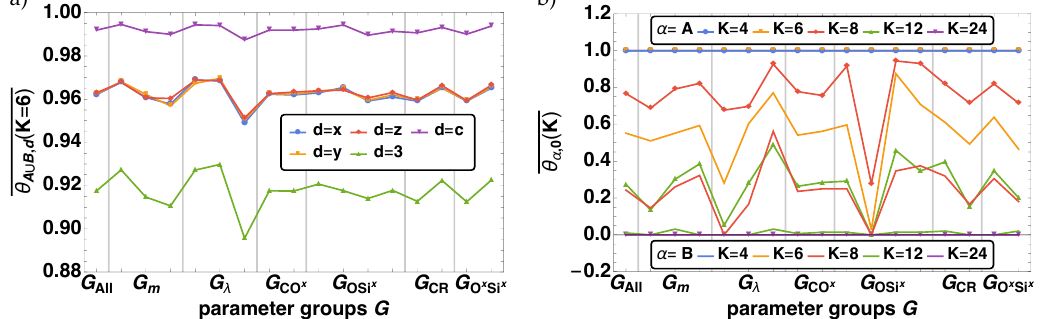
Figure 12. The averaged total fraction of percolating measurement cells θ α , d ( K ) with θ α , d ( K ) (cid:54) = 0 and 1 are given over the parameter groups G ( i ) (see Table 3). The results are shown in ( a ) for α =A ∪ B, K = 6, and d = { x , y , z ,3, c } , whereas in ( b ) for α = { A, B } and d =